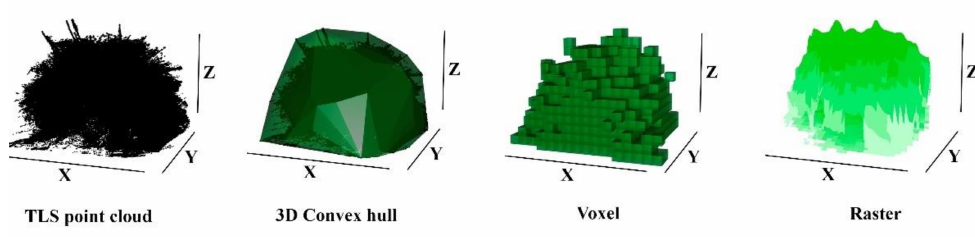
Figure 2. Plant examples of terrestrial laser scanner point clouds obtained by the Laser Leica ScanStation 2 (TLS point cloud) and the three different volumetric models tested in this study: 3D convex hull, the voxel model, and the raster